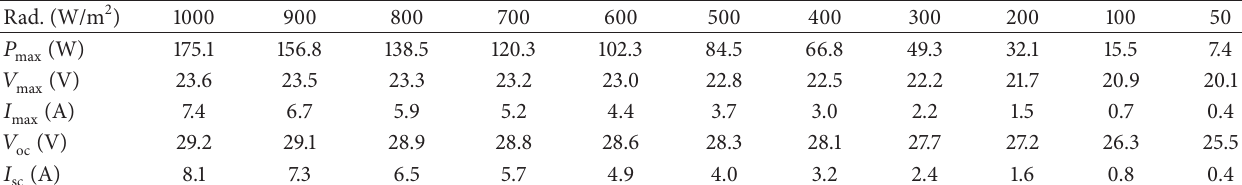
Table 2: Tabular data of I - V curve of the Kyocera KC175GHT-2 at different solar